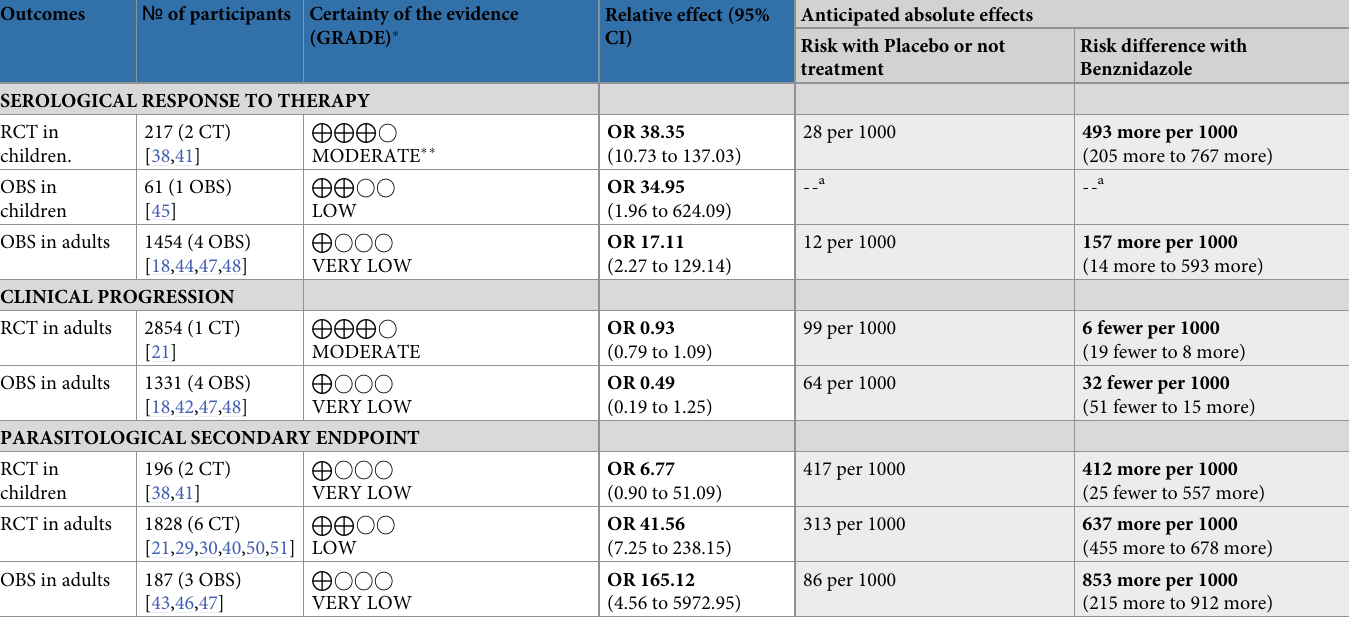
Table 2. Summary of outcomes and certainty of evidence